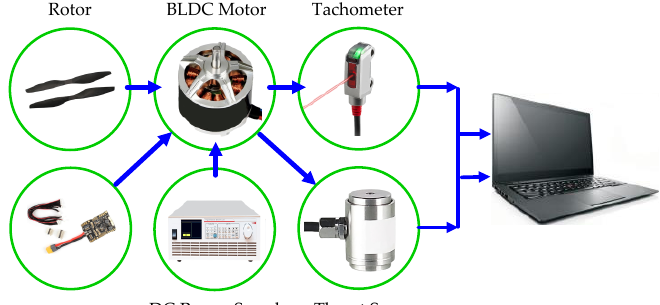
Figure 4. Test section.